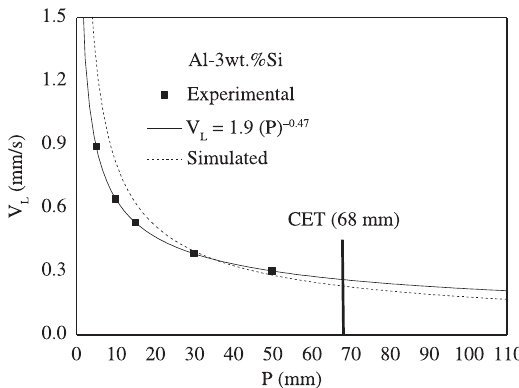
Figure 9. Temperature gradient as a function of position from the metal-mold interface for the Al-3wt.%Si alloy during horizontal